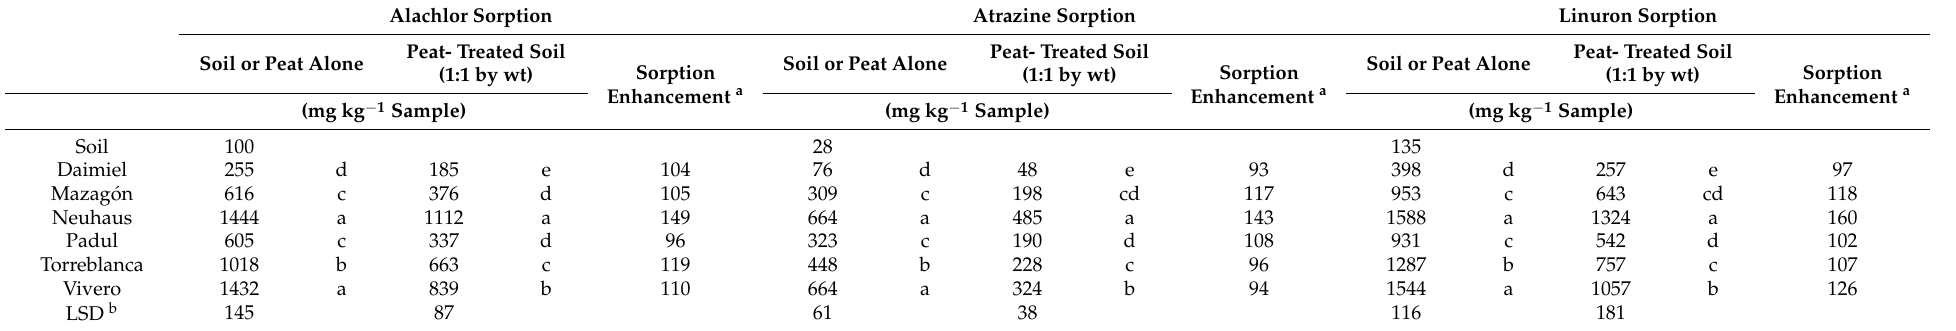
Table 4. Sorption of alachlor, linuron (50 mg L − 1 ), and atrazine (25 mg L − 1 ) in soil, peat, and peat-treated soil samples, and sorption enhancement after peat interaction with soil. Alachlor Sorption Atrazine Sorption Linuron Sorption Peat- Treated Soil Peat- Treated Soil Peat- Treated Soil Soil or Peat Alone Soil or Peat Alone Soil or Peat Alone (1:1 by (1:1 by wt) Sorption (1:1 by wt) Sorption Enhancement a Enhancement a